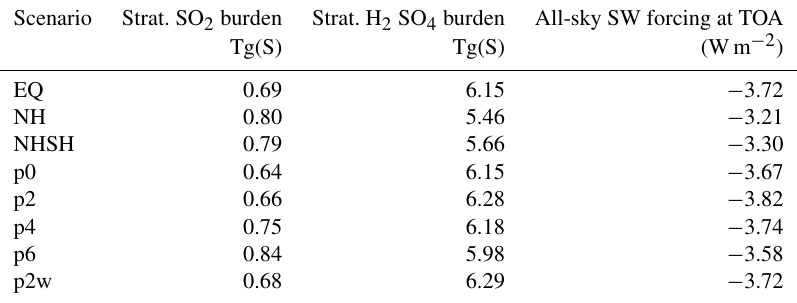
Table 1. The 5-year mean values of the global stratospheric sulfur dioxide and particulate sulfate burdens and the global shortwave (SW) all-sky forcing. In studied scenarios 5Tg(S) of sulfur is injected continuously in latitudes showed in Figs. 1 and 2. Scenario Strat. SO 2 burden Strat. H 2 SO 4